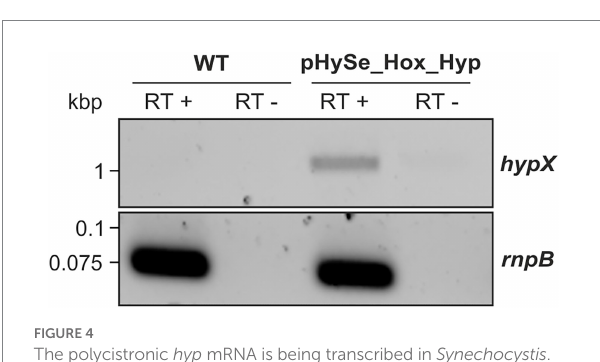
FIGURE 3 HoxJ* and HoxB from C. necator are synthesized in Synechocystis . Western blot for the detection of HoxJ*-FLAG and (~54 kDa) HoxB- FLAG (~40 kDa) fusion proteins. Samples were taken from Synechocystis( Δ hox) that harbored the plasmid pHySe_Hox_Hyp, 24 and 48 h after induction with 0.2% (w/v) L-rhamnose and 5 μ M NiSO 4 . Protein extract of a Synechocystis wild type (WT) strain served as negative control. CE, crude extract; SE, soluble extract.